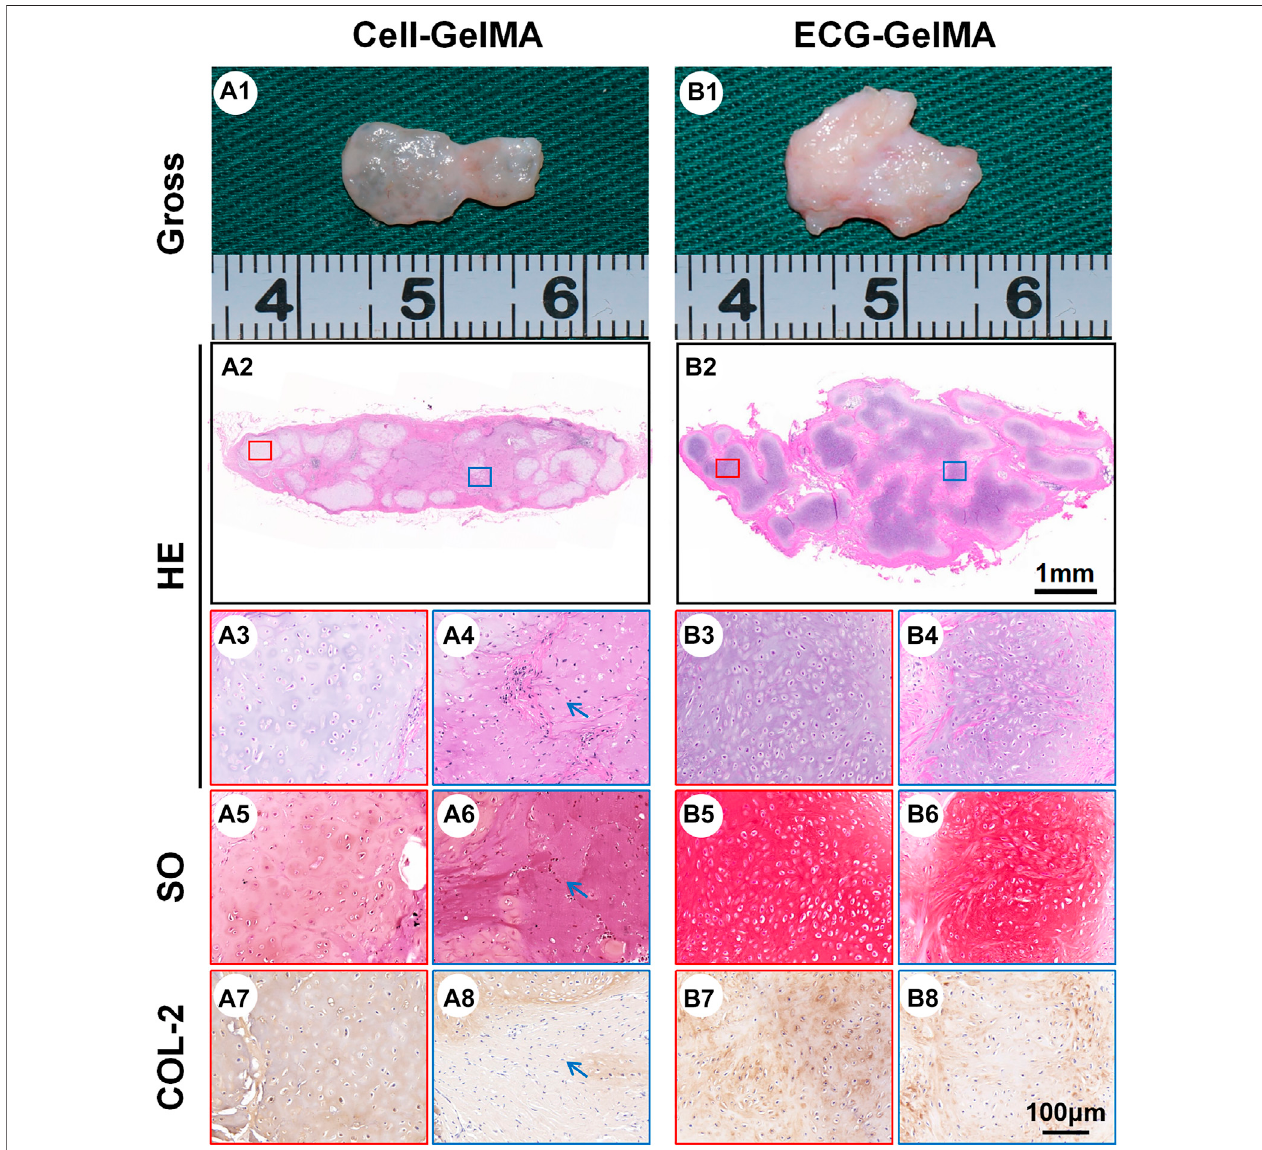
FIGURE 7 | Cartilage regeneration of Cell-GelMA and ECG-GelMA subcutaneously implanted in goat for 12 weeks. Gross view (A1 and B1), HE (A2-A4, and B2- B4), SO (A5-A6 and B5-B6), and immunohistochemical COL-2 (A7-A8 and B7-B8) staining of Cell-GelMA (A) , and ECG-GelMA (B) . The blue box represents magni fi ed imagesatinner zoneofregenerated cartilage, and thered box representsmagni fi ed images at peripheral zone ofregenerated cartilage.Theblue arrows indicate fi brous tissue.